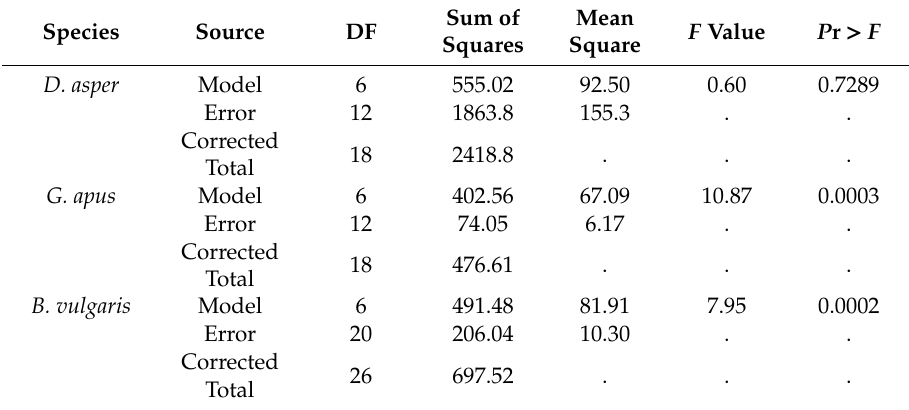
Table A4. Result of the analysis of variance (ANOVA) among the deuterium signature ( δ D, % (cid:24) ) in di ff erent organs of B. vulgaris , G. apus, and D. asper where culms had been labeled 40 days earlier: signature in rhizomes, from di ff erent culm lengths, and from branches and leaves. The bamboos were cut down for the experiment. ‘ P > 0.05 ( P r > F )’ indicate equal variance among